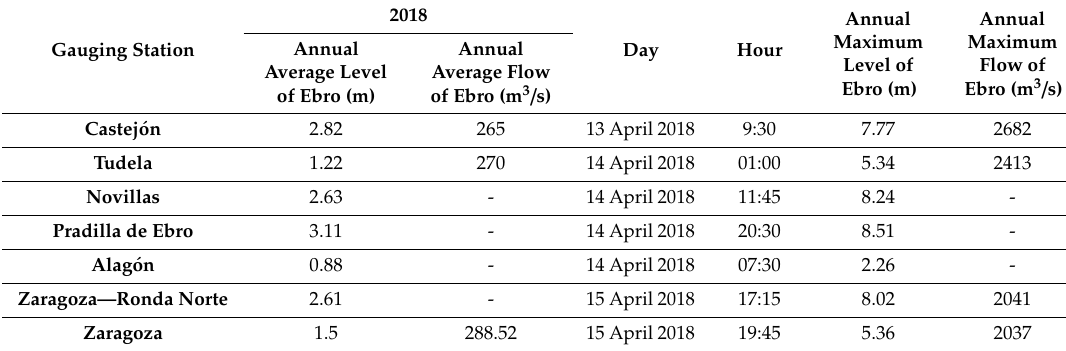
Table 2. Representative values on the annual levels and flows of the Ebro river in different stations located in its course for the year 2018. Historical data taken from the SAIH of the CHE, 2019.